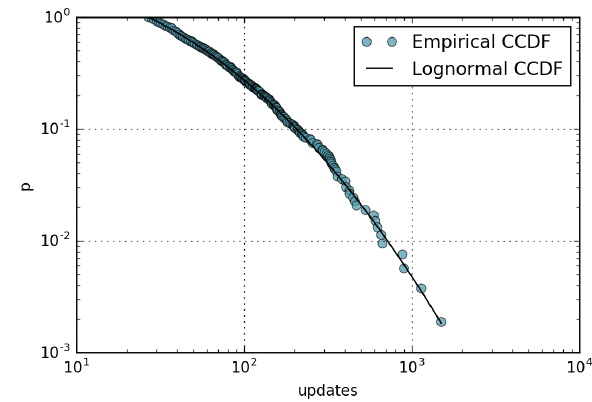
Figure 4. Revisions of the 1000 most popular Wikipedia pages in February